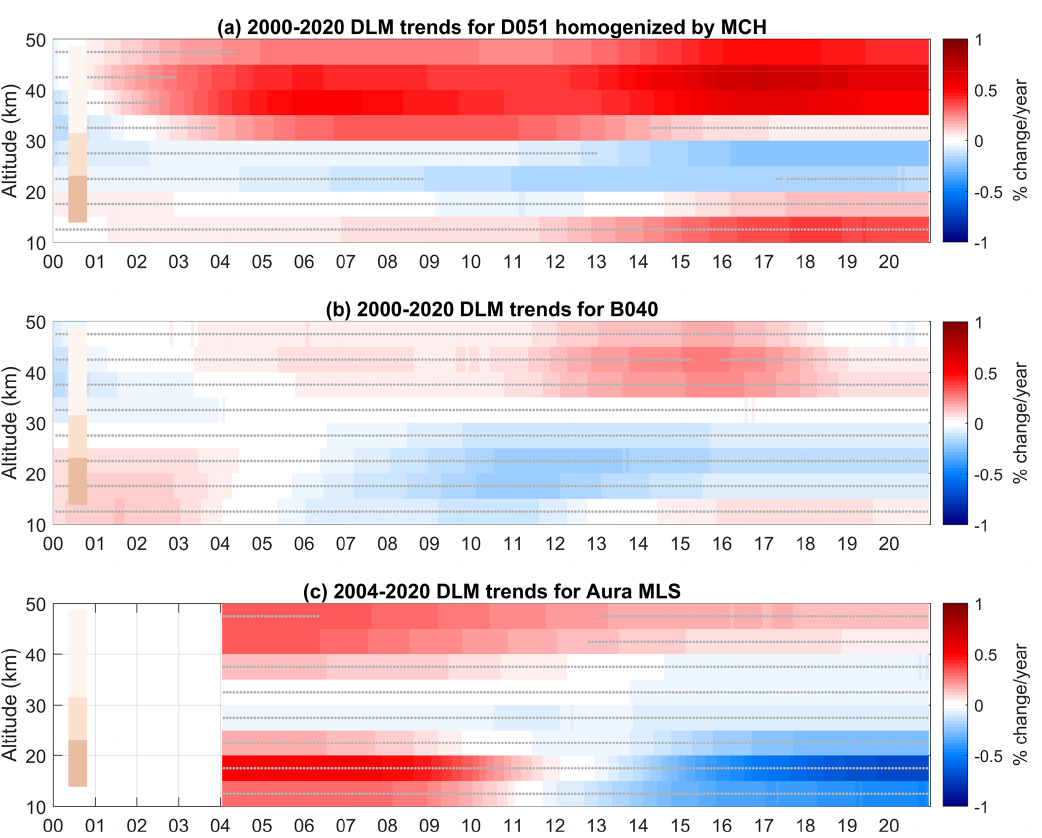
Figure 8. Post 2000 DLM trend estimates in percent per year from (a) Dobson D051, (b) Brewer B040 and (c) Aura MLS data records. Grey lines indicate trend estimates nonsignificantly different from zero at the 95% confidence level. The beige bars indicate the lower, middle and upper stratospheric